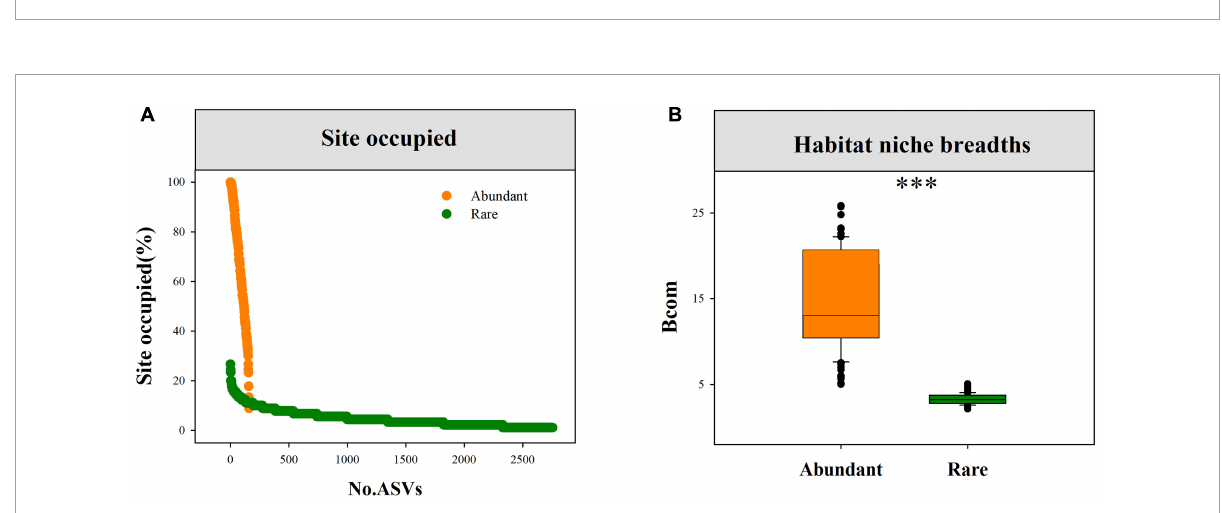
FIGURE2 The proportion of sites occupied for each abundant and rare fungi (A) , and the difference in mean habitat niche breadths (Bcom) between abundant and rare fungal subcommunities (B) , and ∗∗∗ P < 0.0001; Wilcoxon rank-sum